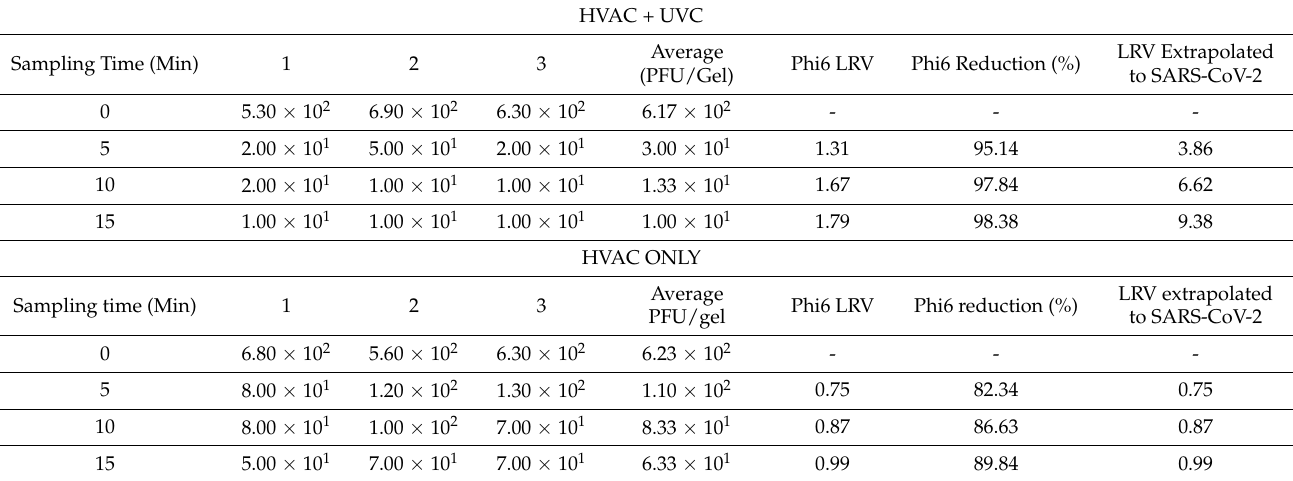
Table 1. Disinfection performance of UVC LEDS fitted into the automobile HVAC system against bacteriophage Phi6, a SARS-CoV-2 surrogate. Performance increase against SARS-CoV-2 is attributed to its higher sensitivity to UVC. HVAC +